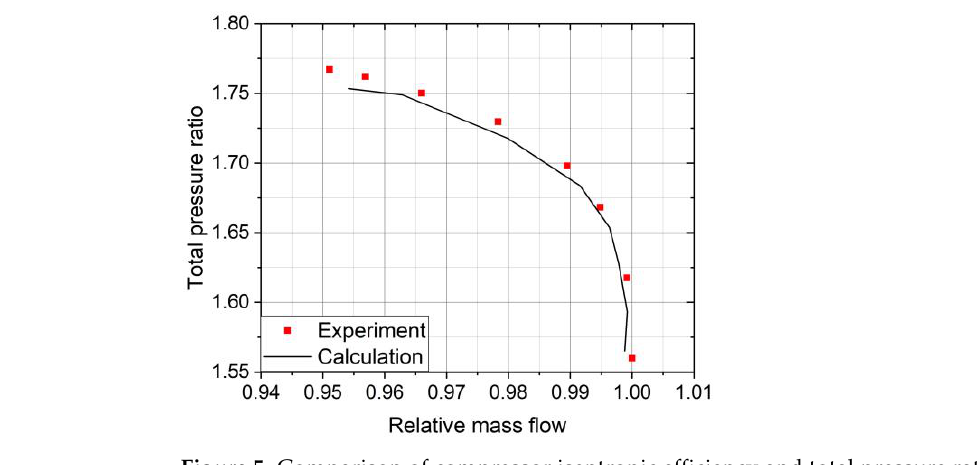
Figure 5. Comparison of compressor isentropic efficiency and total pressure ratio between experi- mental and numerical results.